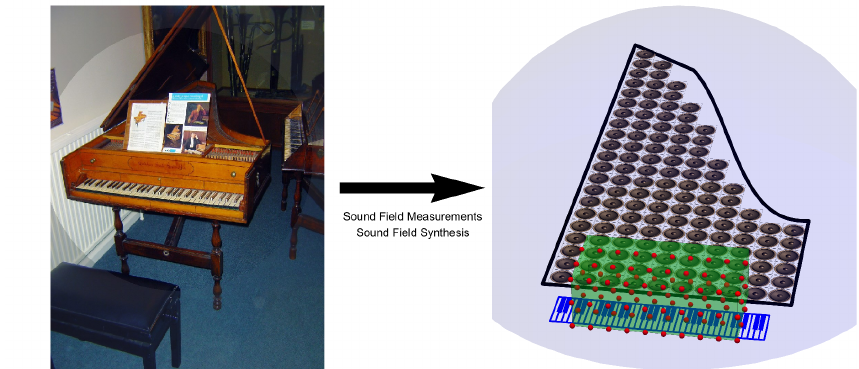
Figure 1. Design and concept of the radiation keyboard ( right ). A MIDI keyboard triggers individual signals for 128 loudspeakers, which are arranged like a harpsichord. Replacing the real harpsichord ( left ) by the radiation keyboard creates only subtle audible differences. Unfortunately, the radiation keyboard cannot synthesizes the harpsichord sound in the complete space. Low frequencies f1 are synthesized with high precision in the complete half-space above the loudspeaker array (light blue zone). Mid frequencies are synthesized with high precision in the listening region (green zone) in which the instrumentalist is located. The sound field of very high frequencies is synthesized with a high precision at discrete listening points within the listening region (red dots).